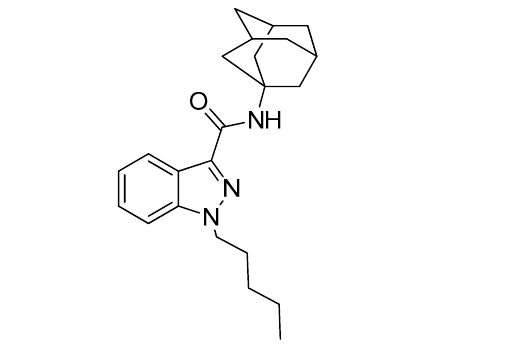
Figure1. ChemicalstructureofAPINACA(AKB48, N Figure 1. Chemical structure of APINACA (AKB48, N -(1-adamantyl)-1-pentyl-1H-indazole-3- carboxamide).